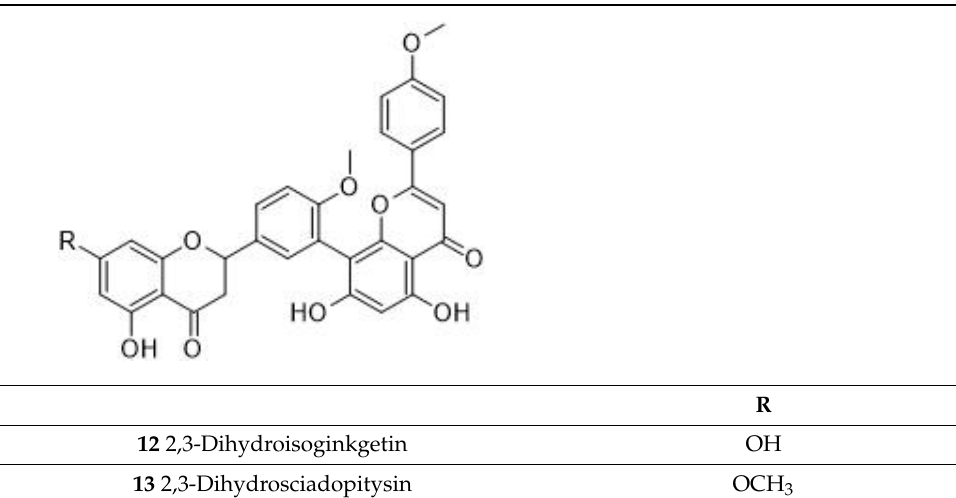
Table 2. The structure of flavanone-flavone type of biflavonoide in ginkgo.